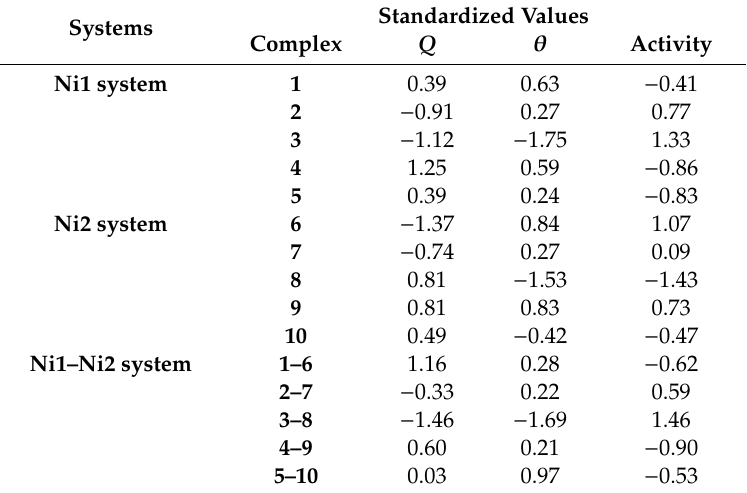
Table 10. Values of contribution of e ff ective net charge ( Q e ff ) and open cone angle ( θ ) for Ni1 complexes, Ni2 complexes and the Ni1 – Ni2 analogue